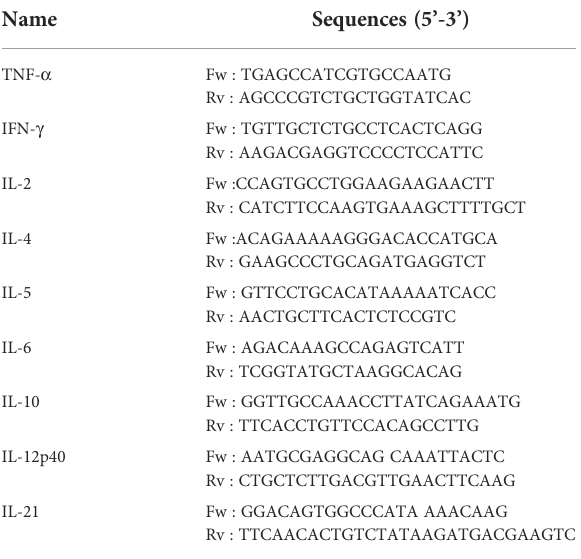
TABLE 3 Primer sequences for each target cytokine